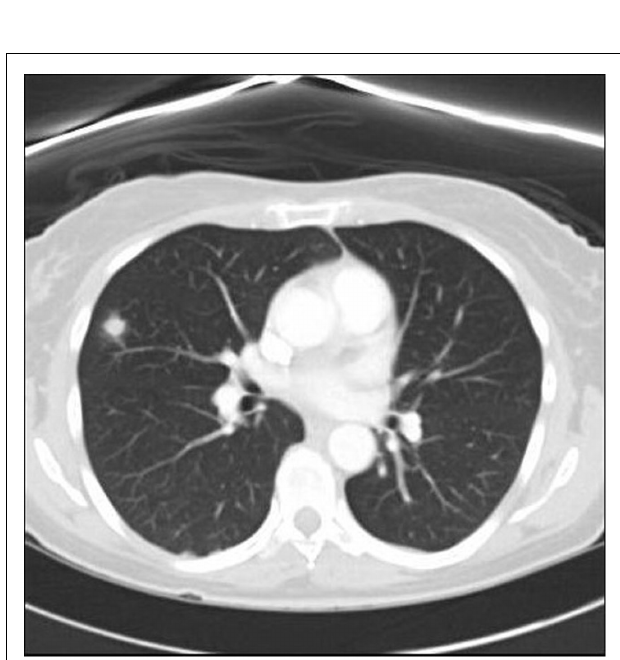
FIGURE 2 | Chest CT shows the dominant nodule located on the right superior lobe.